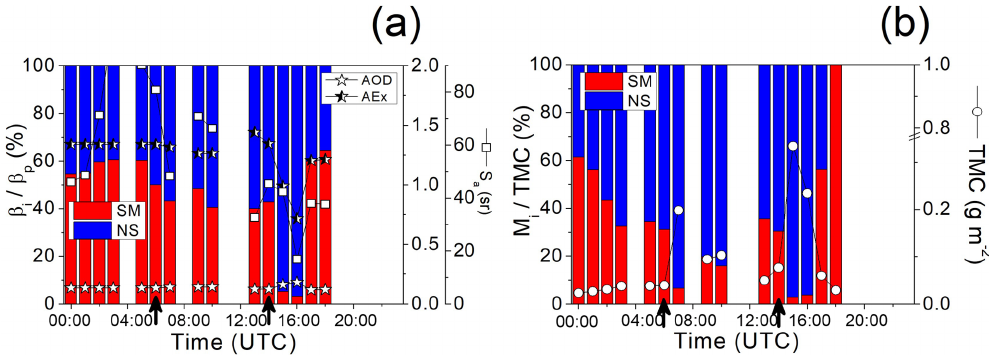
Figure 5. The same as Fig. 3 but for the smoke case on 23 May 2016: SM (red bars) and NS (blue bars) denote smoke and non-smoke components. Black arrows on the time axis indicate selected times for vertical profiles shown in Fig.